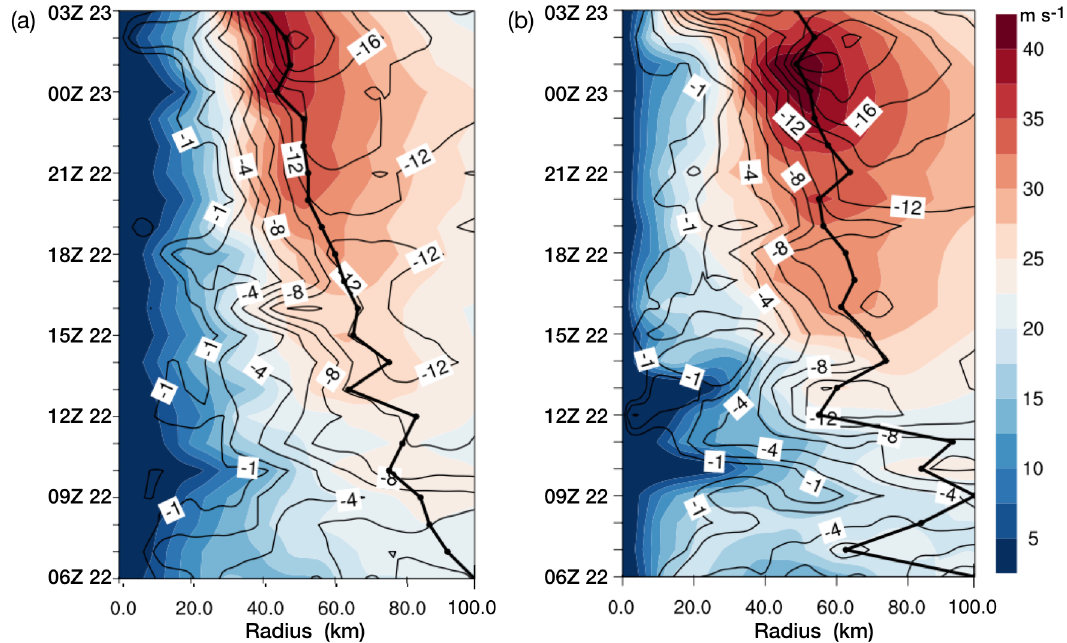
Figure 9. Radial-time cross section of the azimuthally averaged tangential wind (shade, m s − 1 ) and radial wind (contours, m s − 1 , negative values indicated the inflows) on the lowest model level ( ∼ 30 m altitude) for ( a ) CPL experiment and ( b ) FO experiment. The thick solid line with dots denotes the RMW in both experiments. Ordinate values are time from 0600 UTC on 22 August to 0300 UTC 23